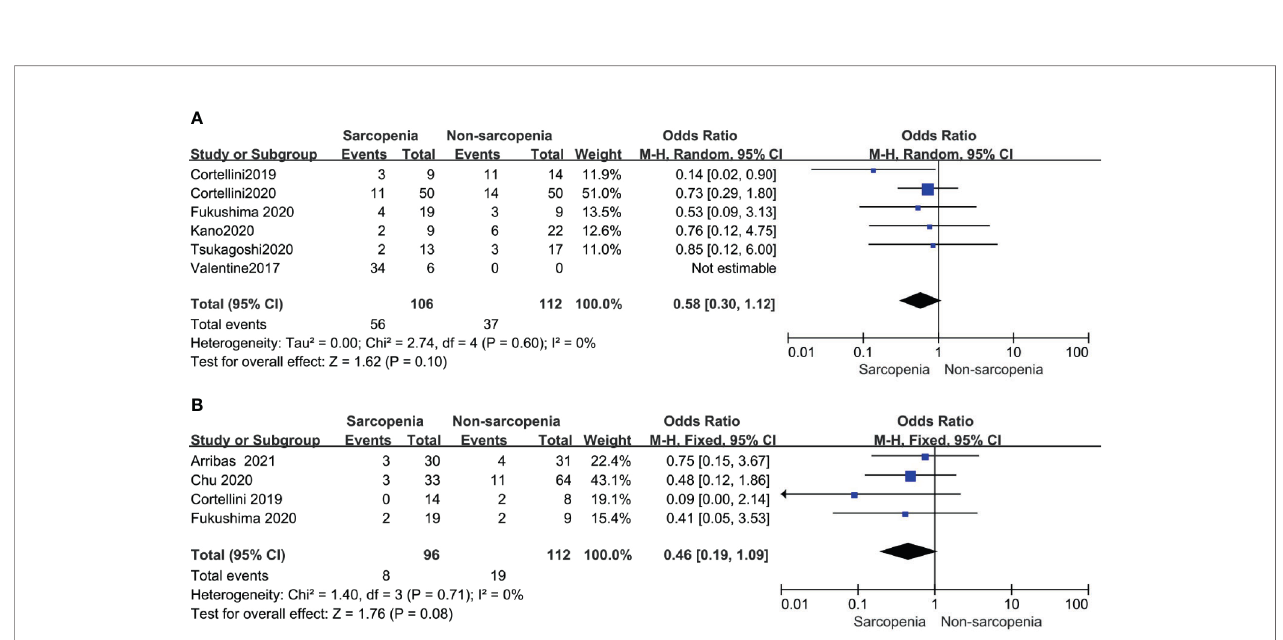
FIGURE 5 | Forest plot of impact of sarcopenia on iAEs (A) . Sarcopenia and any grade iAEs, (B) Sarcopenia and high grade